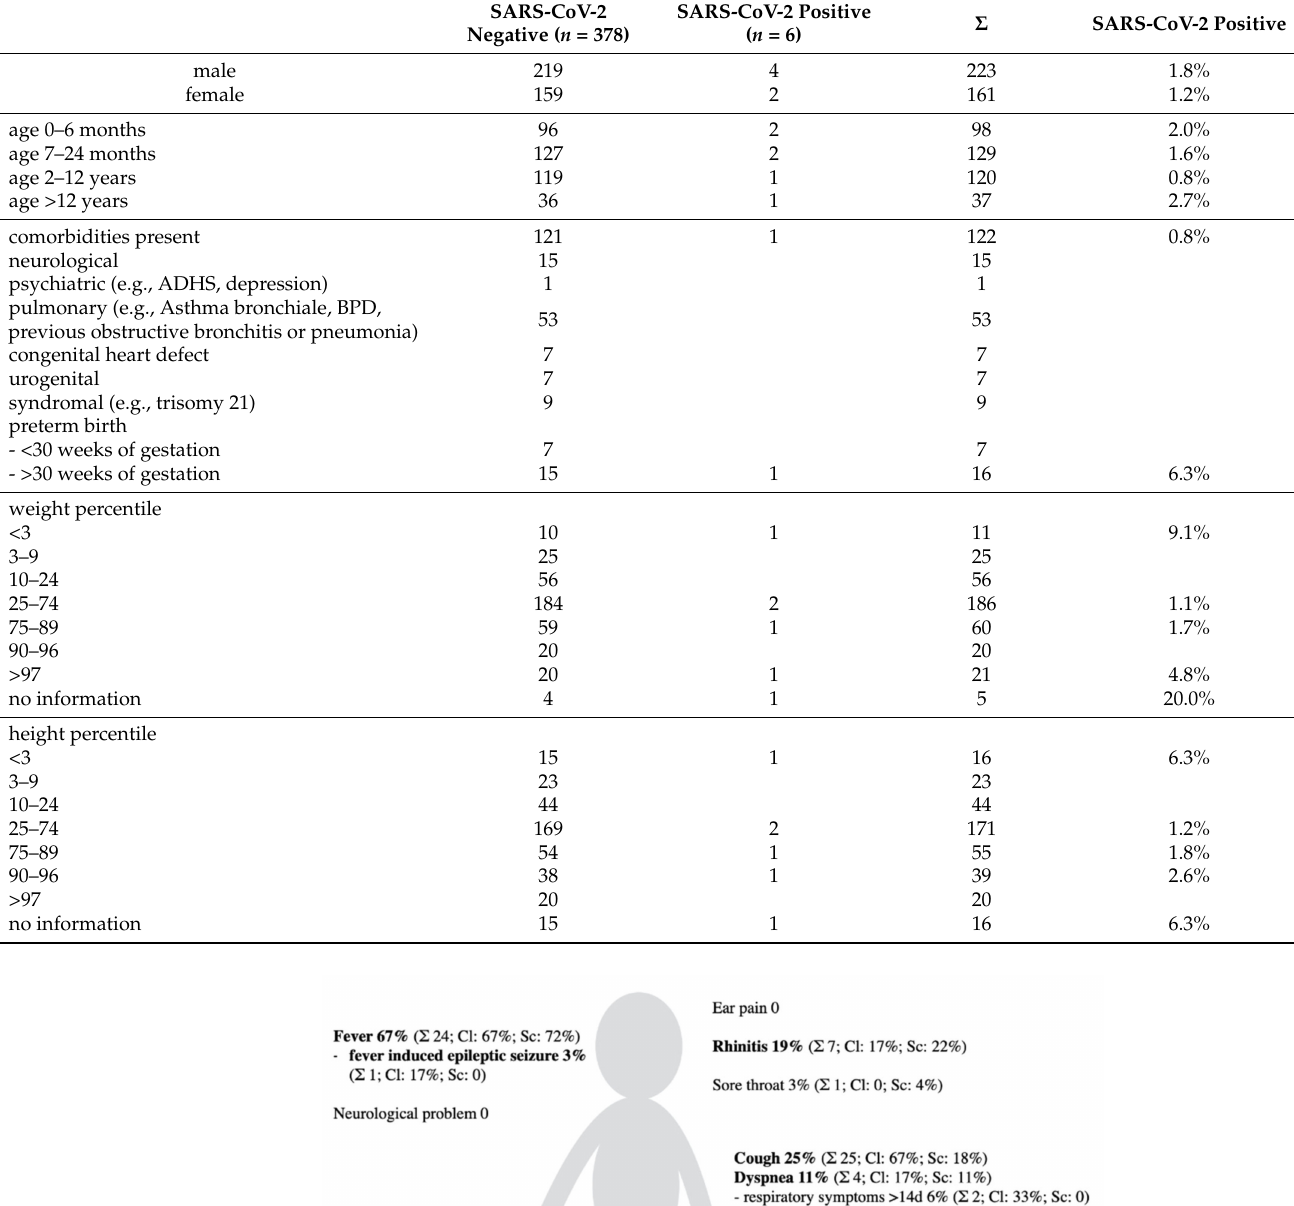
Table 2. Basic characteristics of patients admitted to the pediatric department with clinical suspicion for SARS-CoV-2 infection defined by fever and/or upper respiratory tract infection and/or diarrhea in children ≤ 6 months.